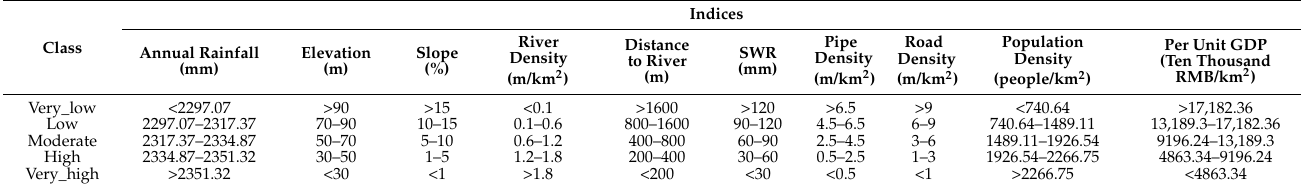
Table 1. Factors divided into five classes using the manual classification